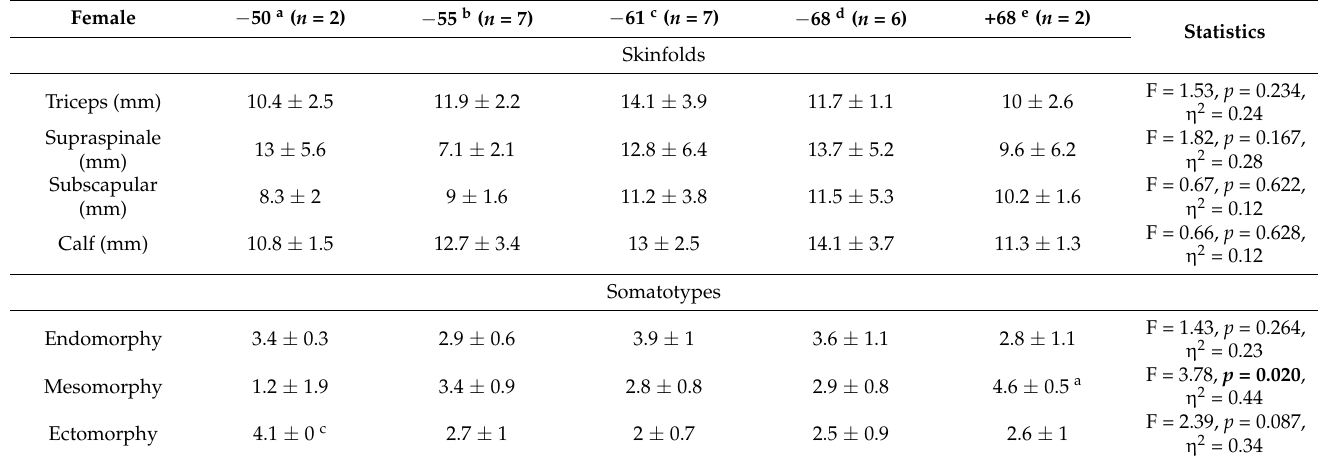
Table 3. Differences between weight categories of female karatekas.